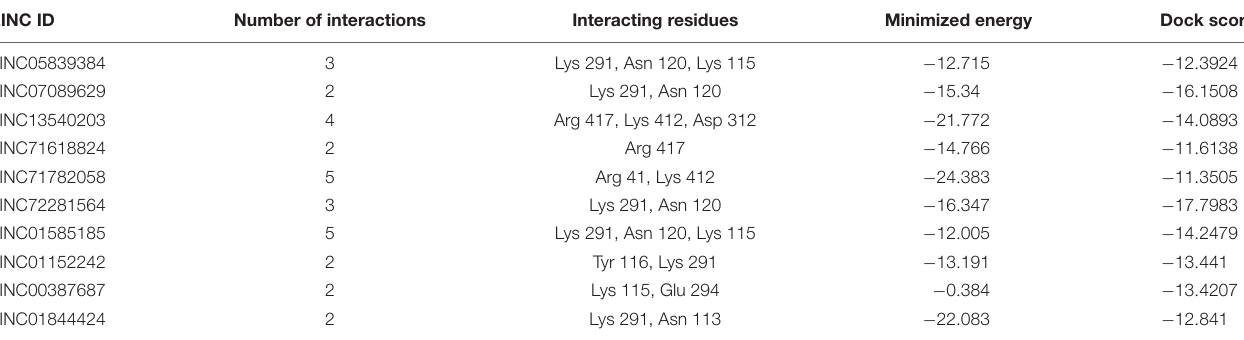
FIGURE 3 | Interaction of 16S rRNA methyltransferase B with ZINC01532584 (colored in red). The interacting residues (green) are shown bonding (dotted lines) with the ligand. TABLE 6 | Chromosomal replication initiator protein DnaA and its interaction profile with docked compounds, their ZINC ID, minimized energy, number of interactions, dock score, and interactive